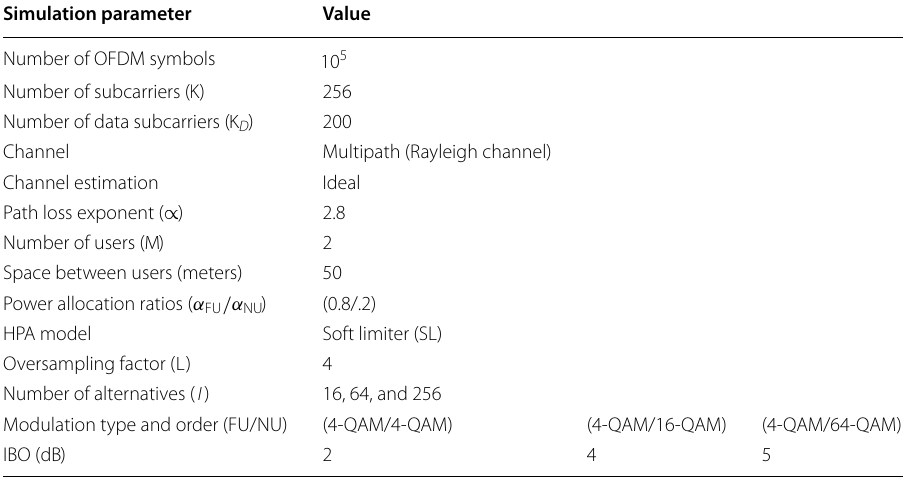
Simulation parameter Value Number of OFDM